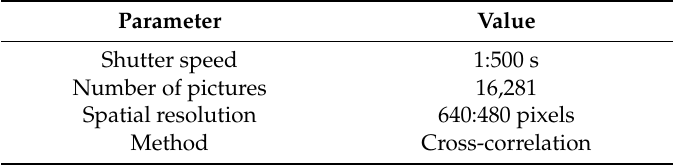
Table 6. Parameter configuration of Particle Image Velocimetry